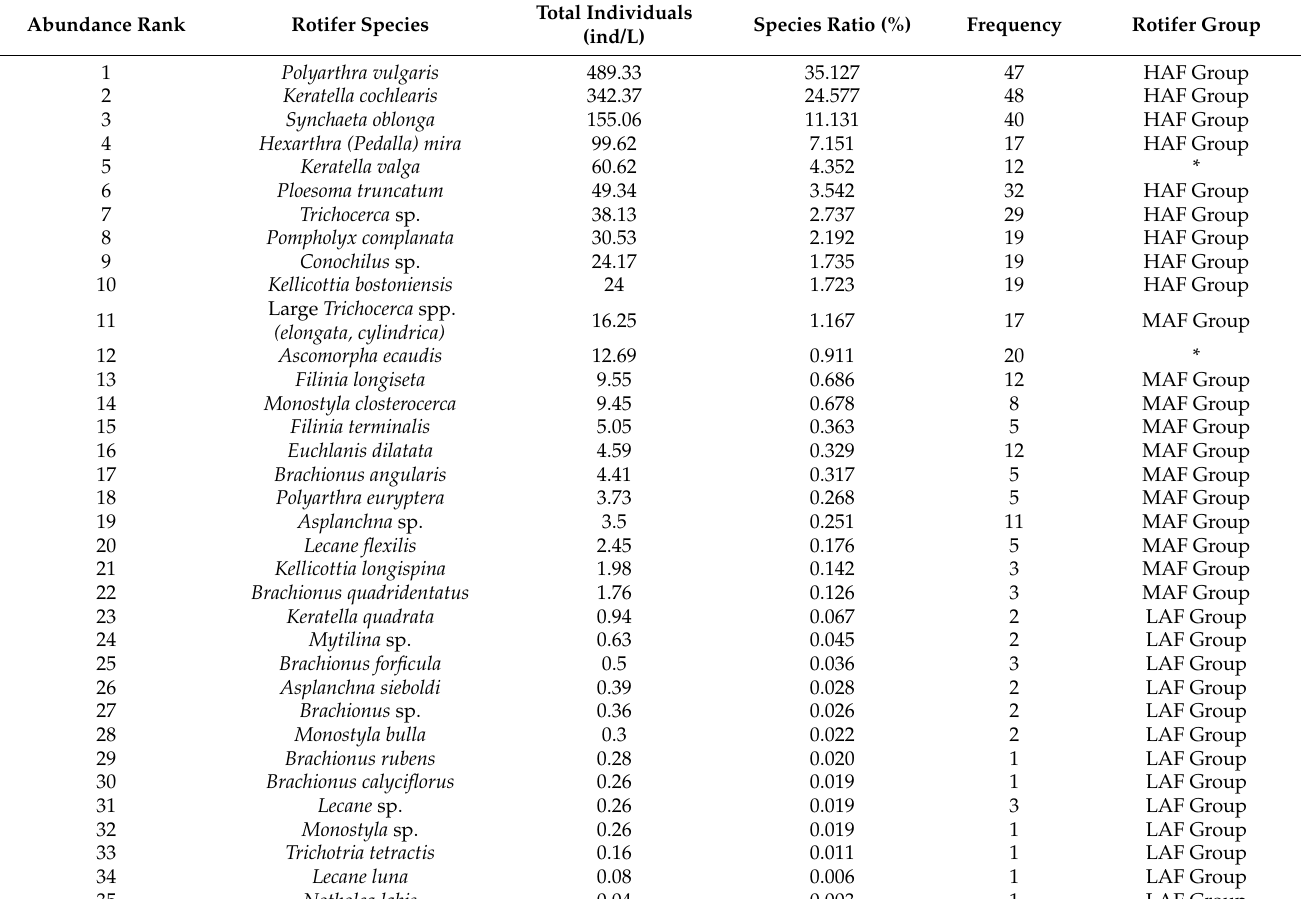
Table 2. Summary of the community data (number of individuals, number of species ratio, and frequency) for rotifer species abundance and frequency 2017–2019 in Daecheong